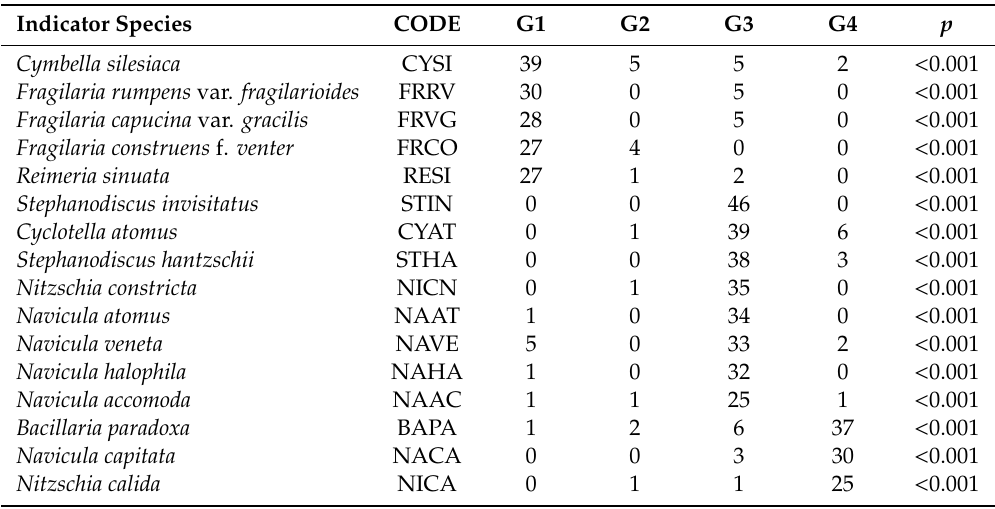
Table 3. Good indicator species and the values (%) of the epilithic diatom communities in Korean peninsula estuaries between 2009 and 2016. Groups were divided by cluster analysis with diatom abundance and